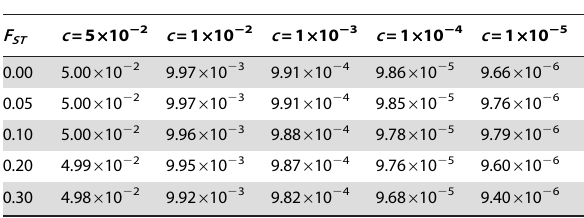
Table 2. Average of empirical proportion at 500K